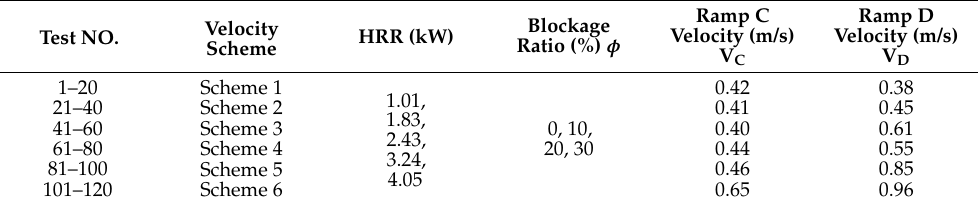
Table 2. Experimental conditions. Test NO.